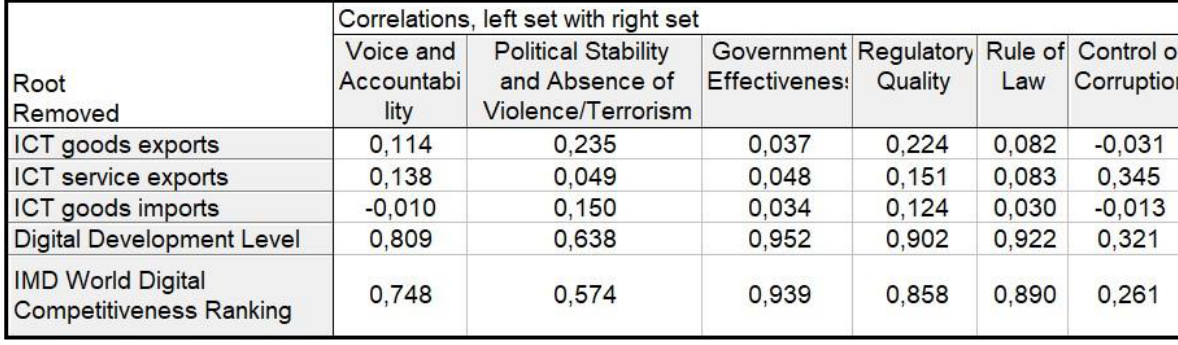
Figure 3. Correlation Between